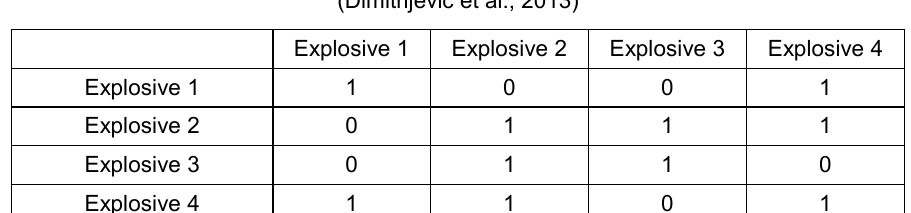
Table 4 –- Storage compatibility mixing matrix (Dimitrijevi ć et al., 2013) Таблица 4 – Матрица комбинирования совместимых взрывчатых веществ при